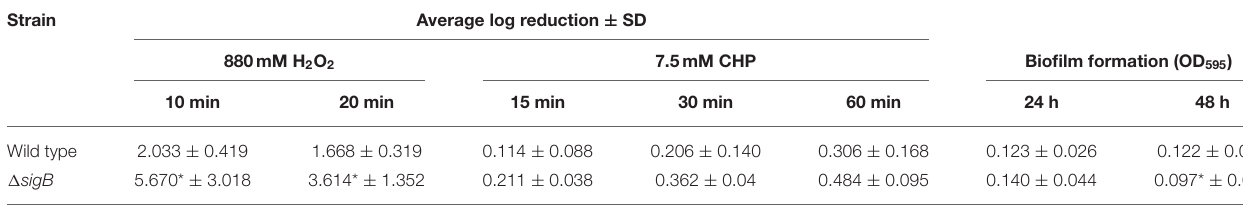
TABLE 3 | Summary of phenotypic characterization of wild type and 1 sigB mutant.